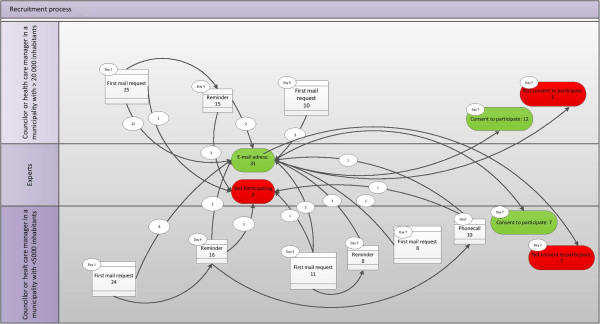
Recruitment process.